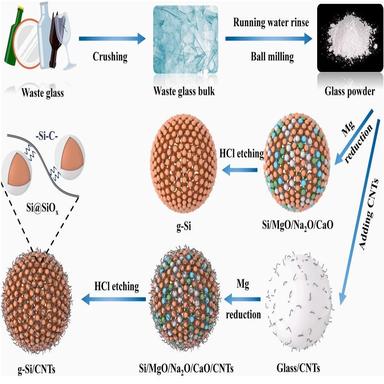
Schematic illustration of synthesis of the g-Si/CNTs composite.